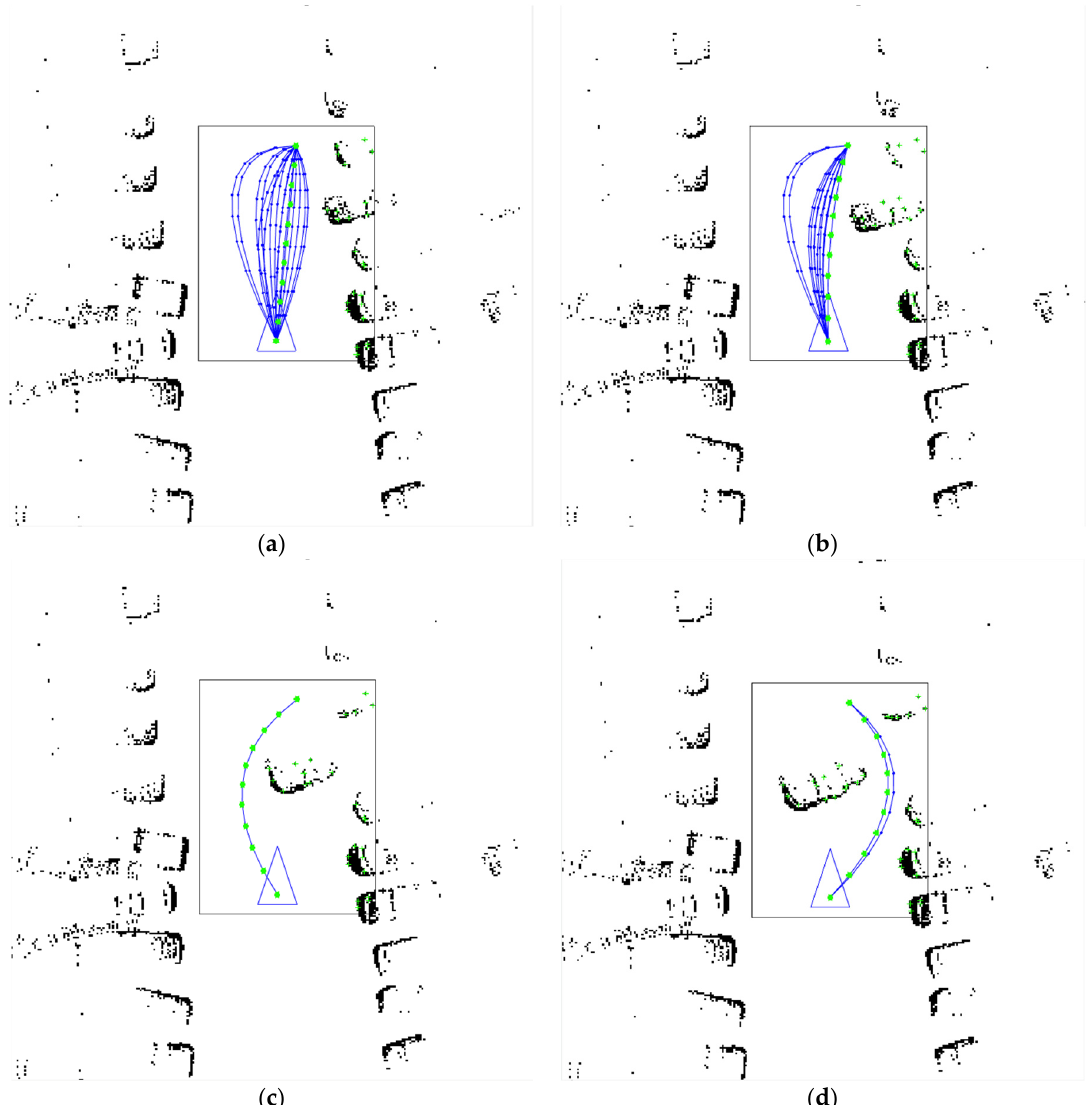
Figure 10. ( a ) Scenario 1; ( b ) scenario 2; ( c ) scenario 3; ( d ) scenario 4 (nCurves = 30, safety distance = 1 m, criteria = minimum